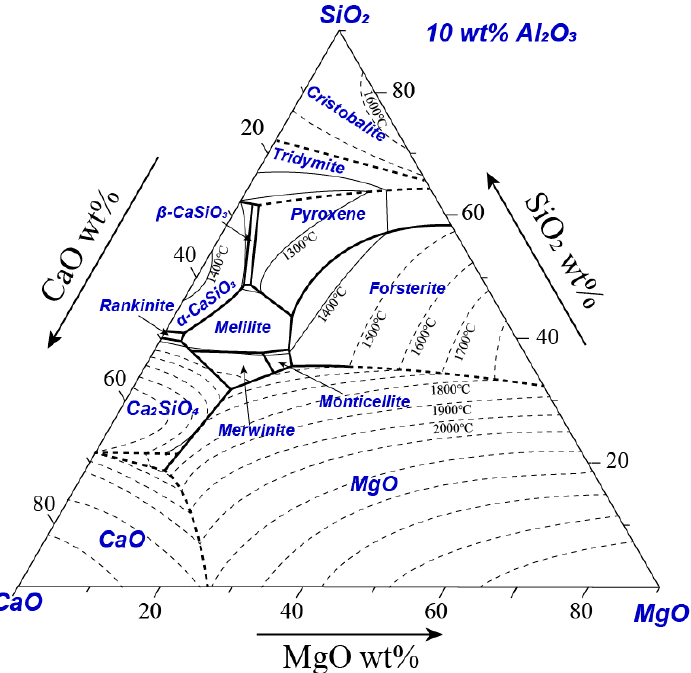
Figure 4. Pseudo-ternary phase diagram CaO-MgO-Al 2 O 3 -SiO 2 for the 10% Al 2 O 3 plane [7].